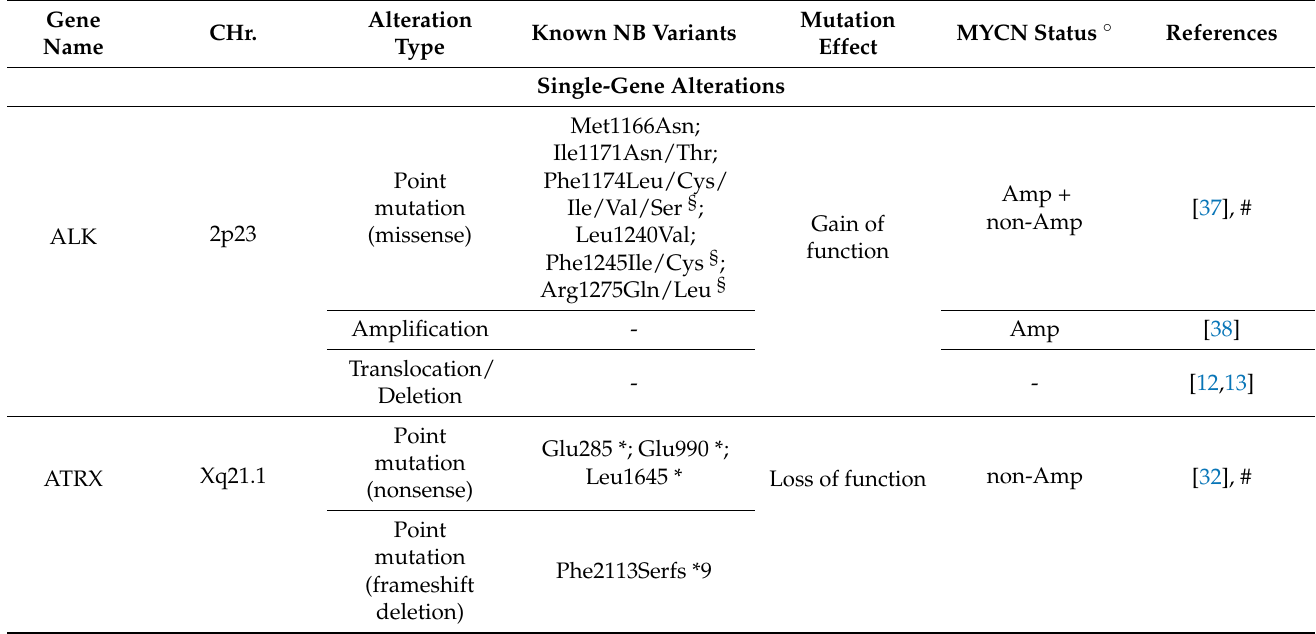
Table 1. Leading genetic alterations in